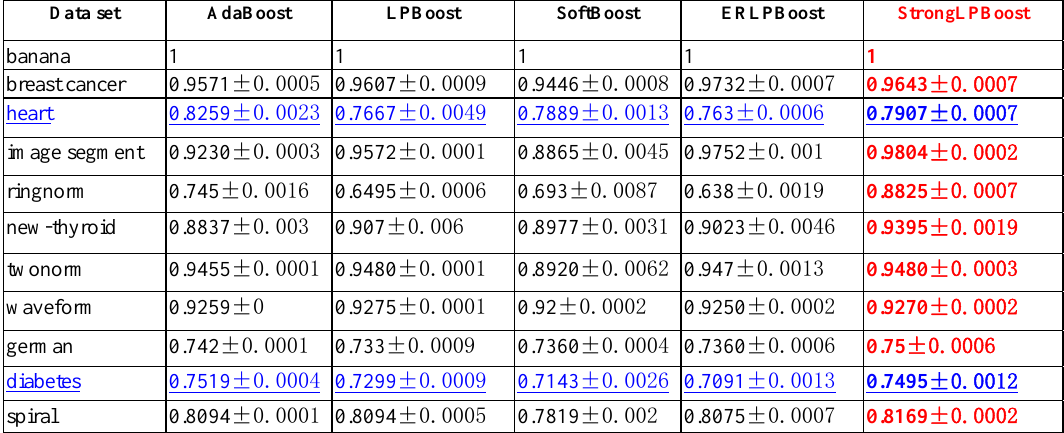
Table 3. Accuracy of 5 algorithms over 11 datasets: the mean and variance of 5-fold-cross validation